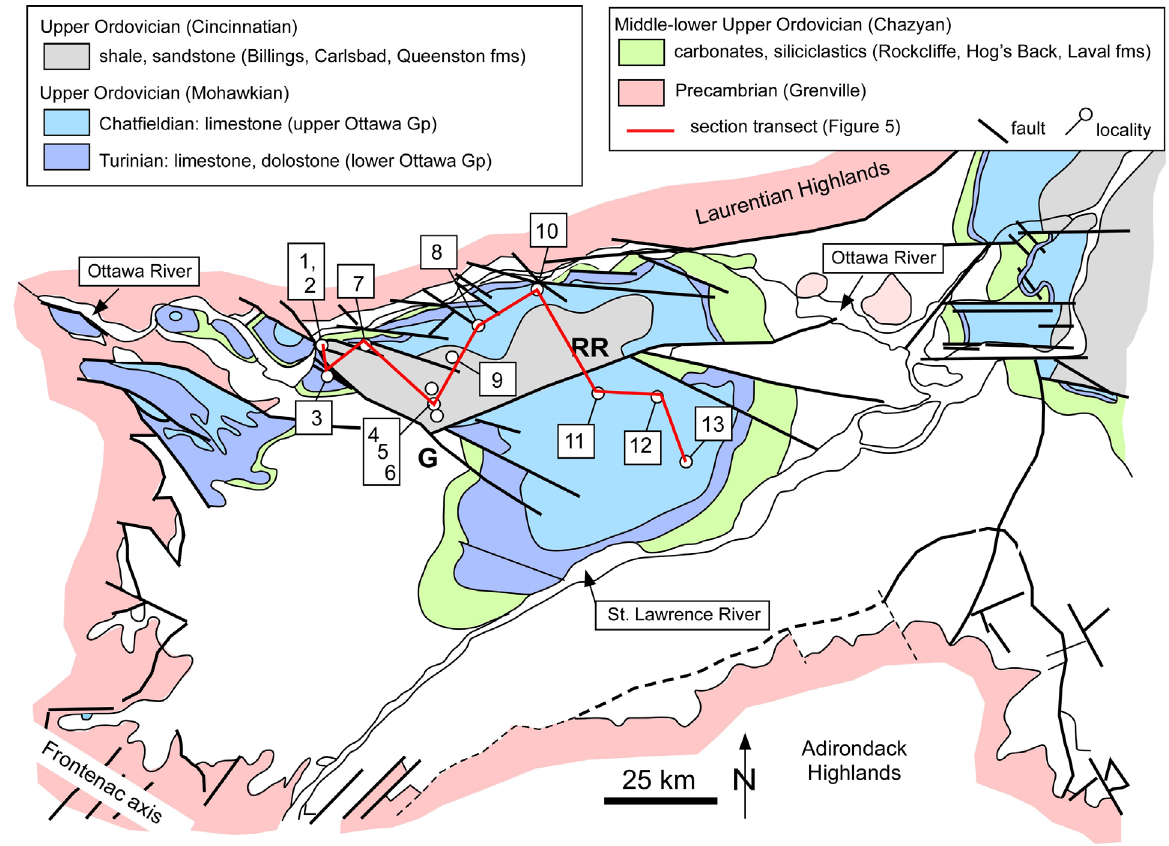
Figure 2. Regional bedrock geology [9,17] showing distribution of the foreland sedimentary succession, section locations, and section transect (see Figure 5). Abbreviations: G, Gloucester Fault; RR, Rigaud-Russell